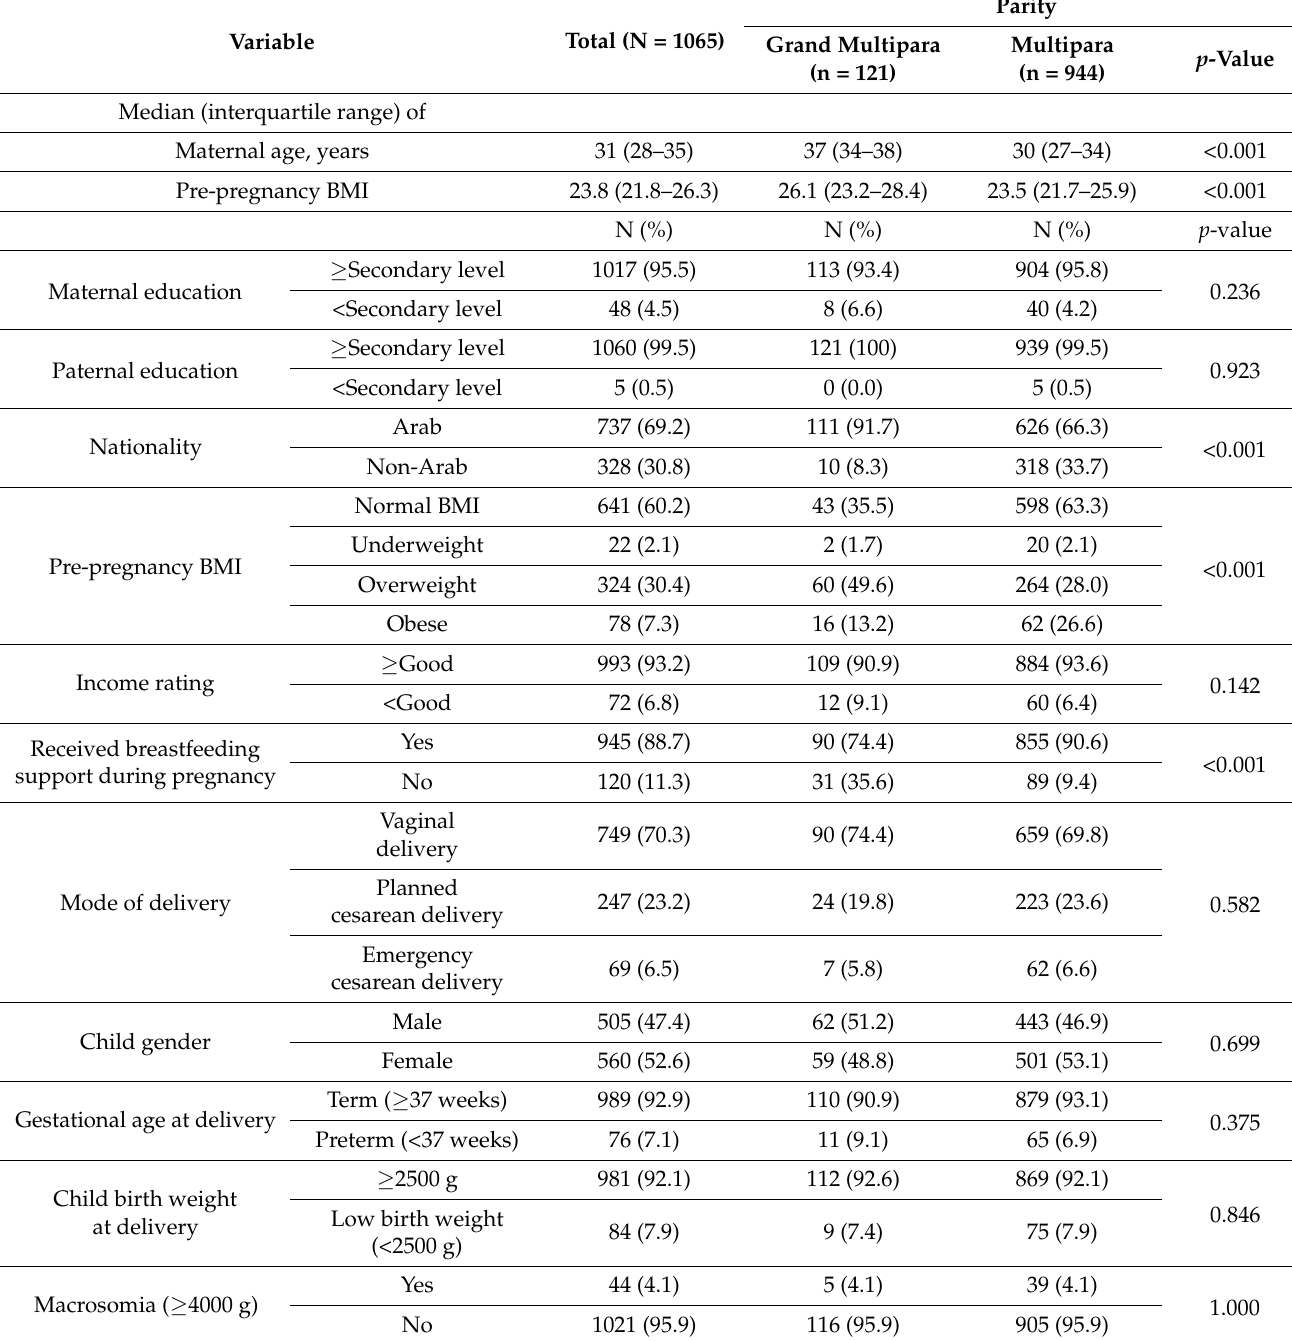
Table 1. Sociodemographic characteristics of the studied participants, Abu Dhabi, United Arab Emirates.